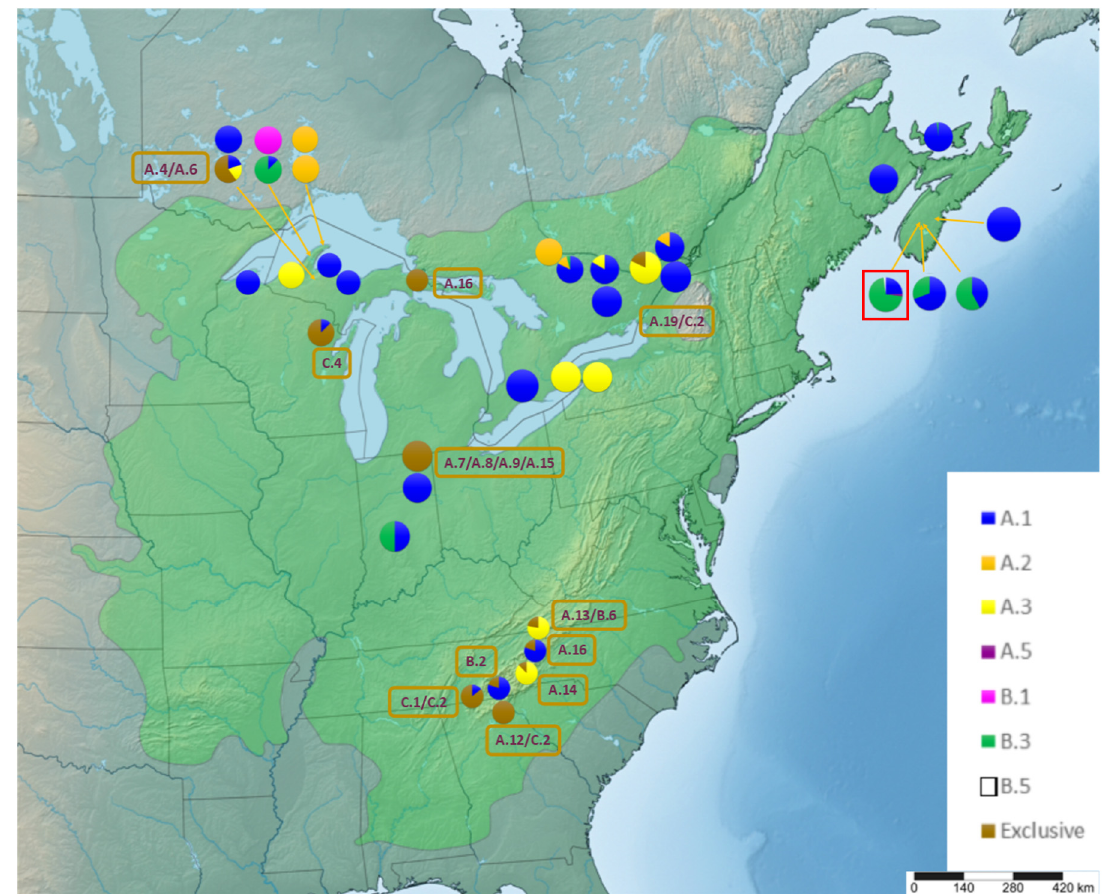
Figure 3. Distribution of Q. rubra chloroplast haplotypes in North America. The native red oak range is highlighted in green. “Exclusive” are haplotypes that were found only in North America, but not in Germany. For better visualization, they were highlighted by brown color and pooled together in pie charts, but their individual names are listed within the brown frames placed next to the respective population. A5 and B.5 were represented by a single tree each in one population of Nova Scotia highlighted by the red frame.